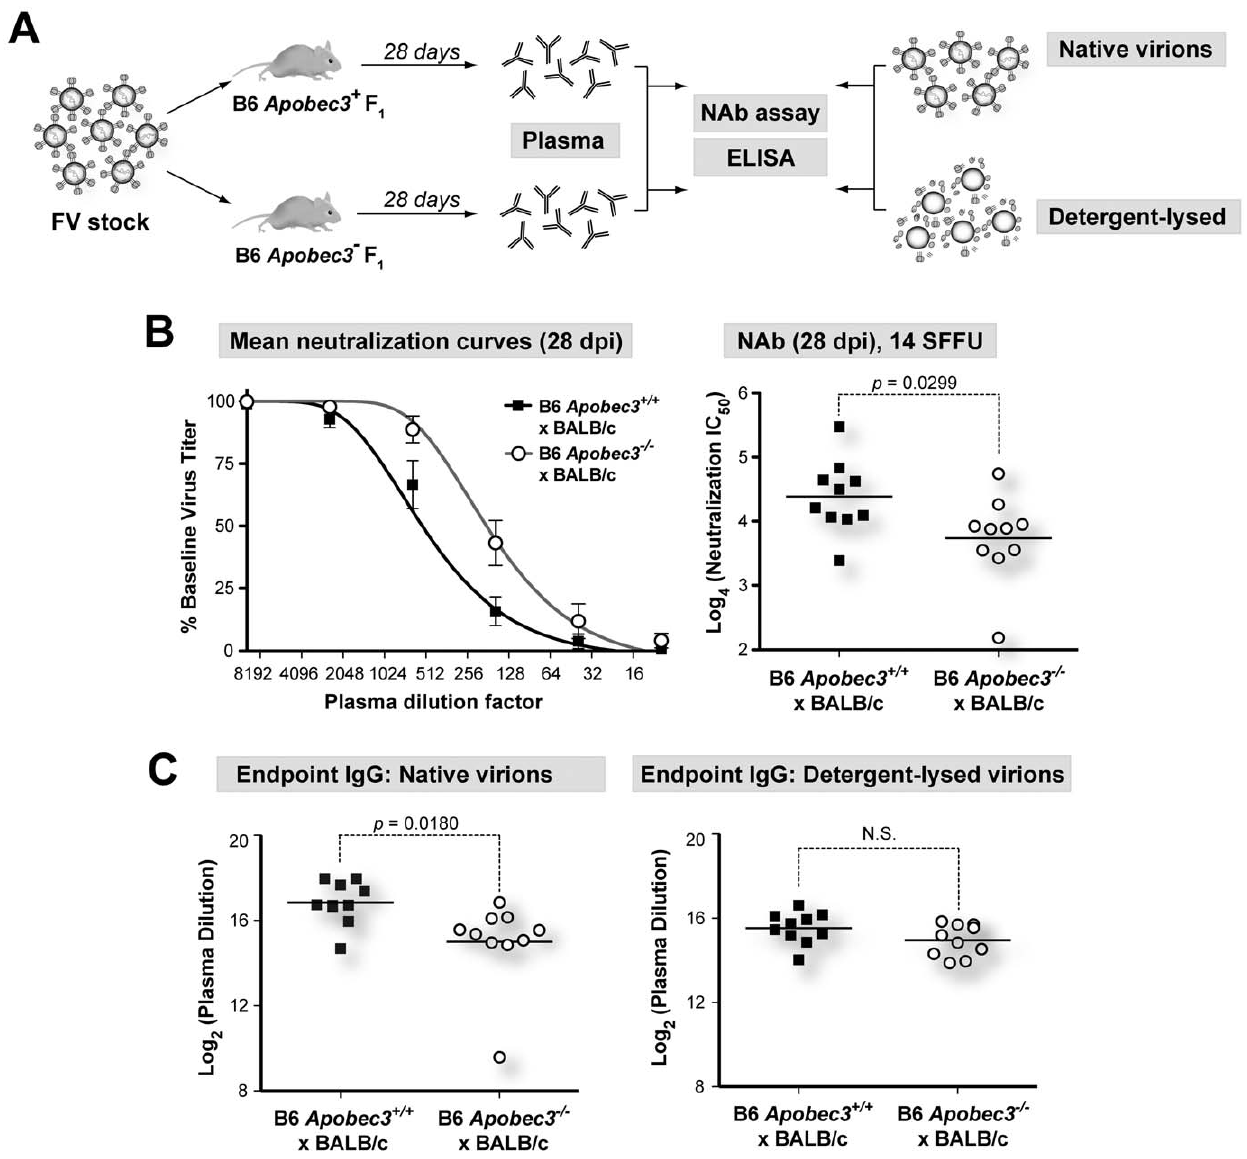
Figure 4. NAb responses in (B6 6 BALB/c)F 1 mice. (A) Plasma samples at 28 dpi from (B6 mA3 + / + 6 BALB/c)F 1 and (B6 mA3 2 / 2 6 BALB/c)F 1 mice were heat-inactivated and analyzed for neutralization potency and virion binding. (B) B6 mA3 influences NAb responses in (B6 6 BALB/c)F 1 mice. ( Left